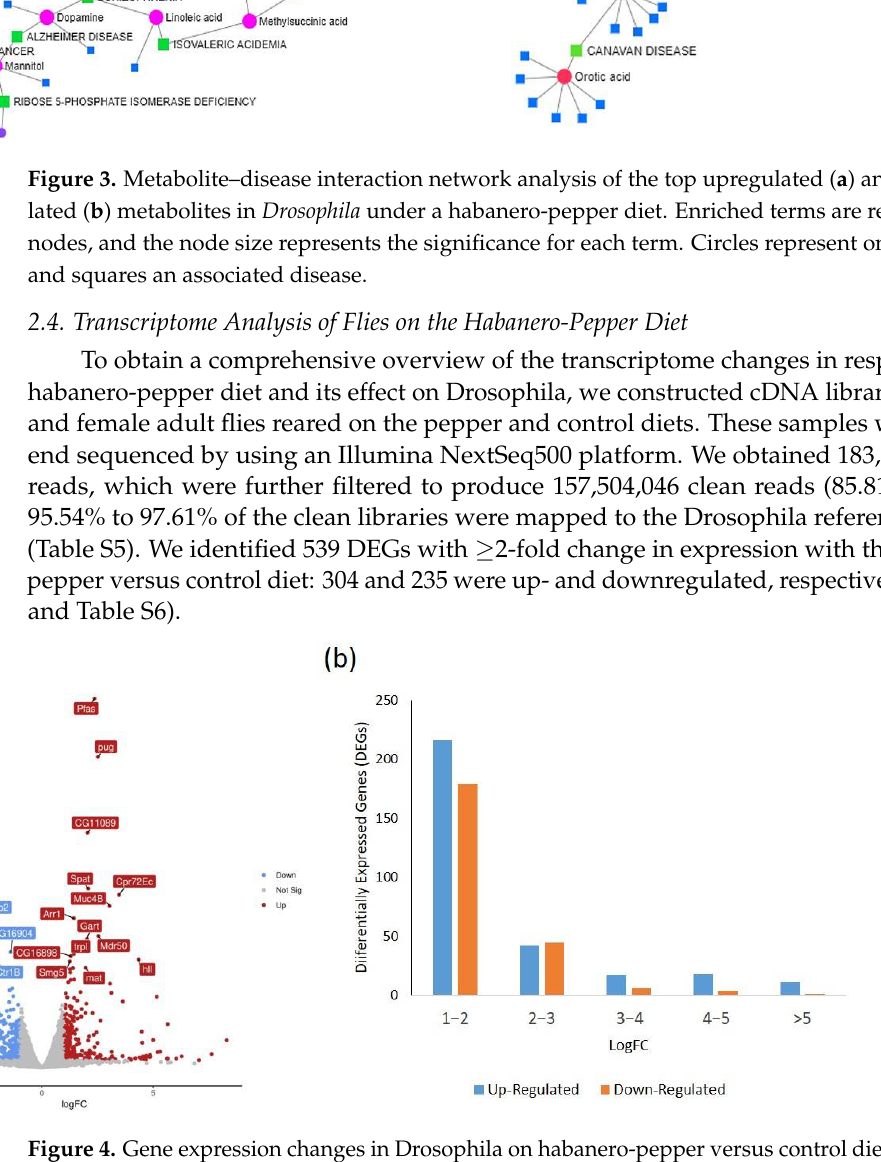
Figure 3. Metabolite–disease interaction network analysis of the top upregulated ( a ) and downreg-